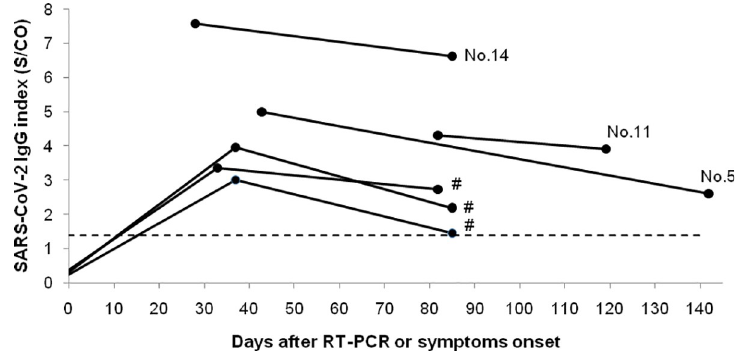
Fig 2. Follow-up serology testing. SARS-CoV-2 IgG follow-up data in 6 HCWs including three seropositive at initial testing (No. 5, No. 11, and No. 14) and three HCWs clustered cases (indicated by #), who had been confirmed with COVID-19 within a week following initial serology testing (in week 27). The dashed line indicates the positivity threshold (1.4 S/CO).